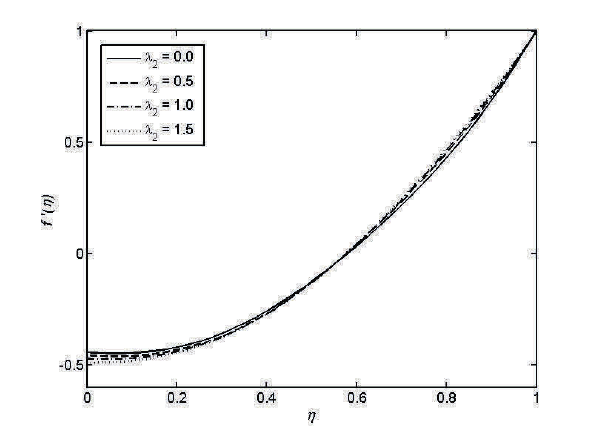
Fig. 6: Variation of f (cid:2) ( η ) for different values of λ 2 for λ 1 = 1 and M = 0.5.